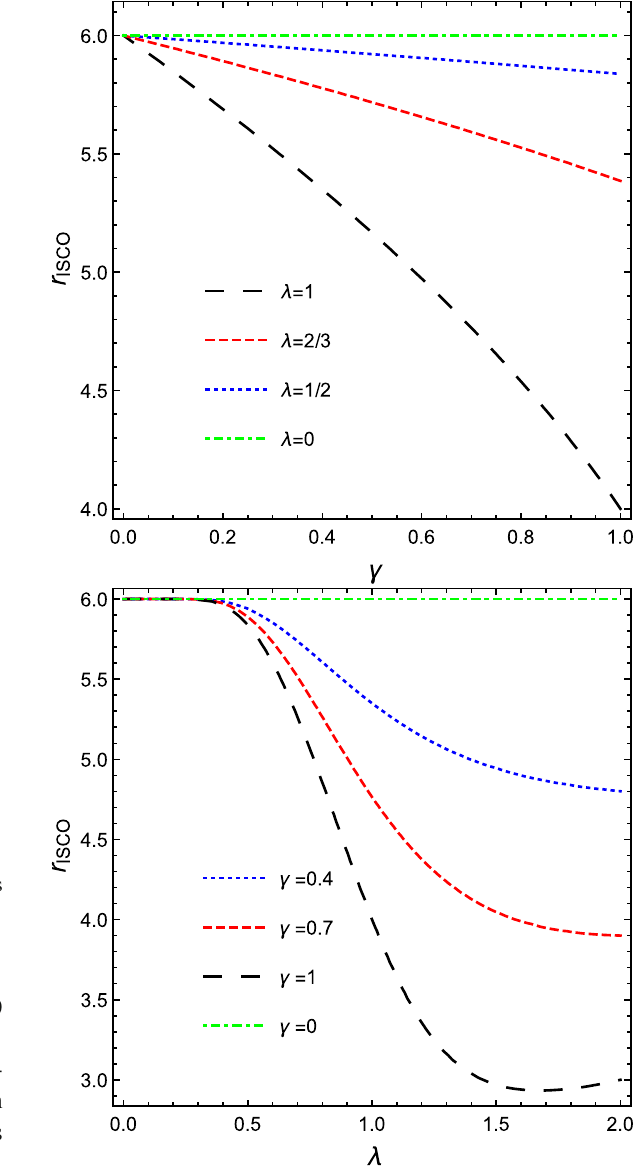
Fig. 5 Relation of r